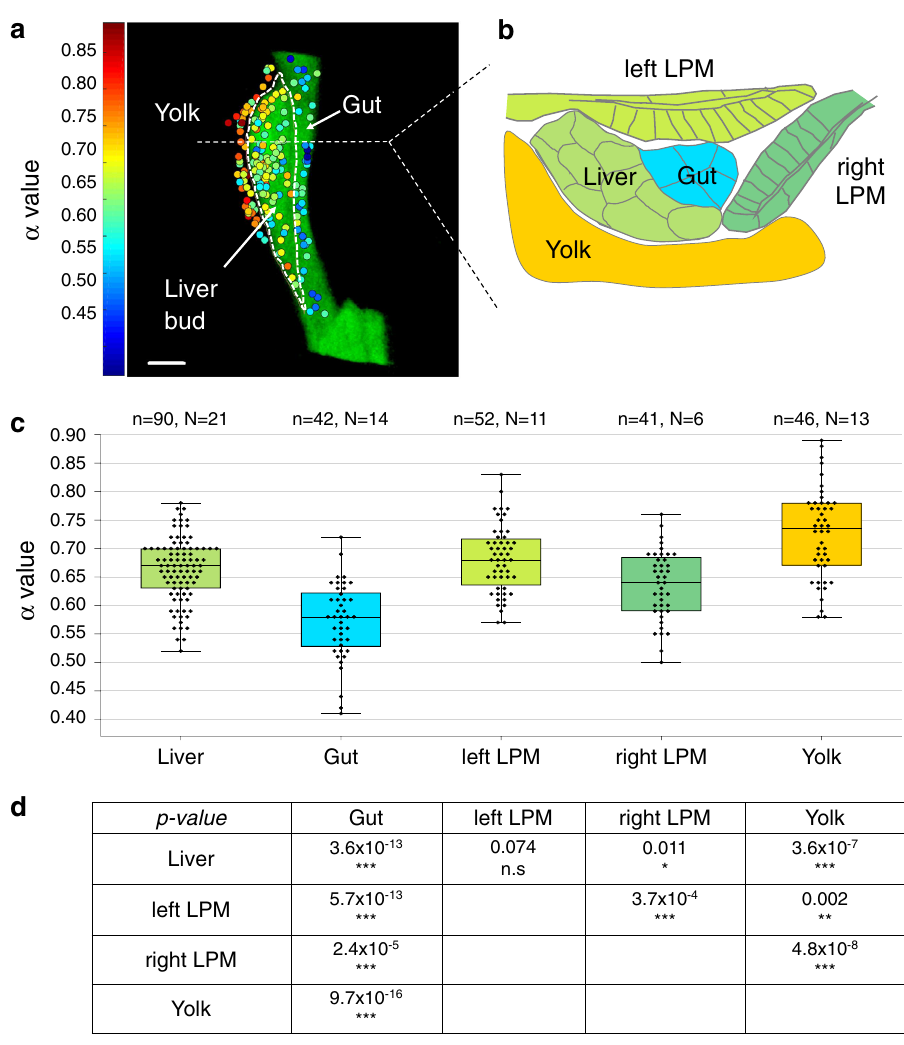
Fig. 3 Viscoelastic mapping of the foregut region reveals different biomechanical properties of neighboring progenitor populations. a 2D projection of viscoelasticity map of the liver, gut, and yolk. The color scale on the left indicates cellular viscoelasticity: increasing blue values show more elastic tissues, while increasing red values represent more viscous tissues ( n = 178 nanoparticles, N = 32 embryos). Scale bar: 20 µ m. b Viscoelasticity map of the foregut region in a projection orthogonal to ( a ) and using color code corresponding to average α values for each tissue type, color scale bar as in ( a ). c Quanti fi cation of α values for different tissues shown in a box plot; n = number of analyzed particles, N = number of embryos. d Statistical comparison of α value distributions between different tissues. The table provides the P value calculated for each pair of tissues using a two-tailed equal variance Student ’